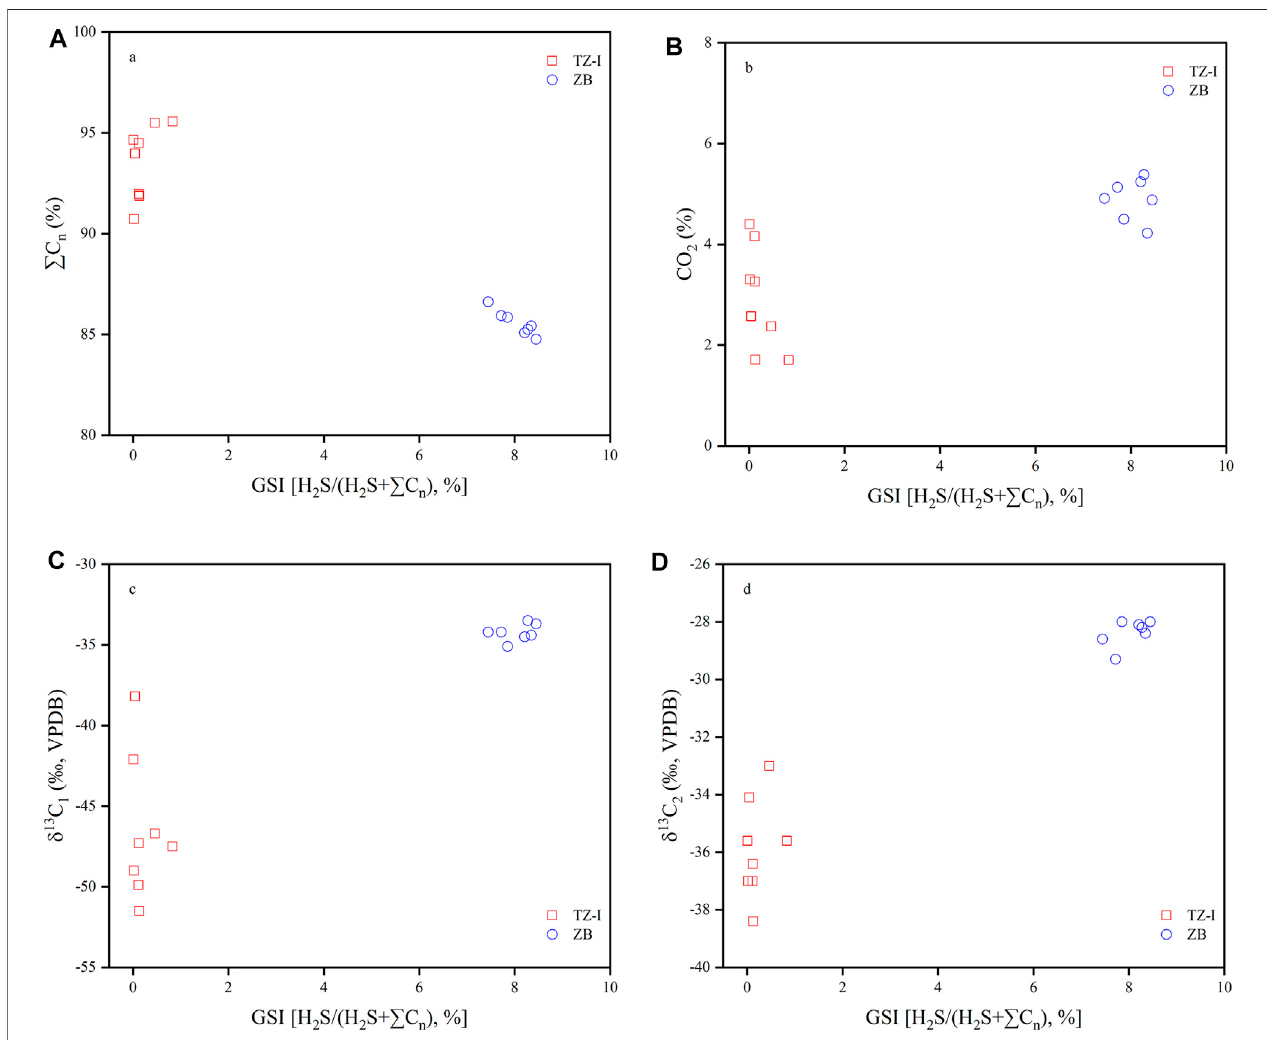
FIGURE 9 | Variation of (cid:1) C n (A) , CO 2 (B) , δ 13 C 1 (C) and δ 13 C 2 (D) with gas souring index (GSI) for natural gases in the TZ-I and ZB gas fi elds, GSI = H 2 S/ (H 2 S+ (cid:1) C n